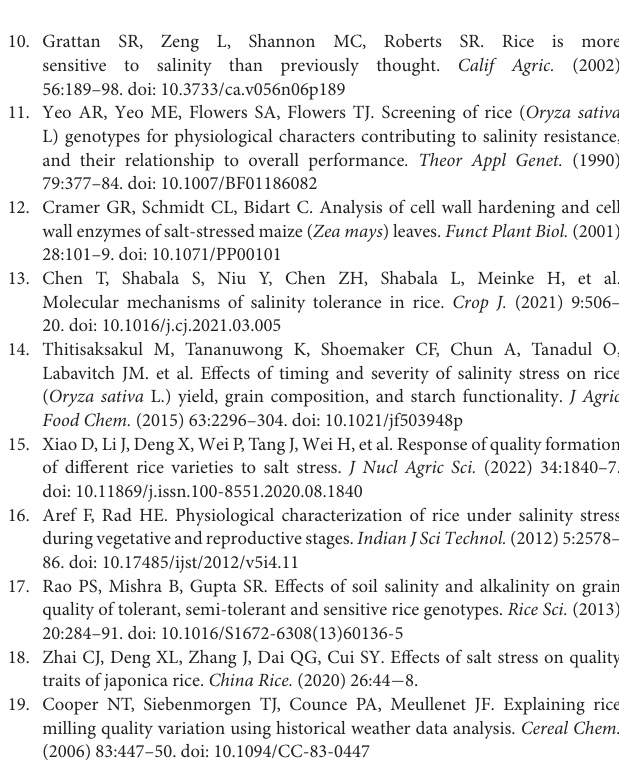
Supplementary Table S2 | Effects of salinity stress on rice milling and appearance